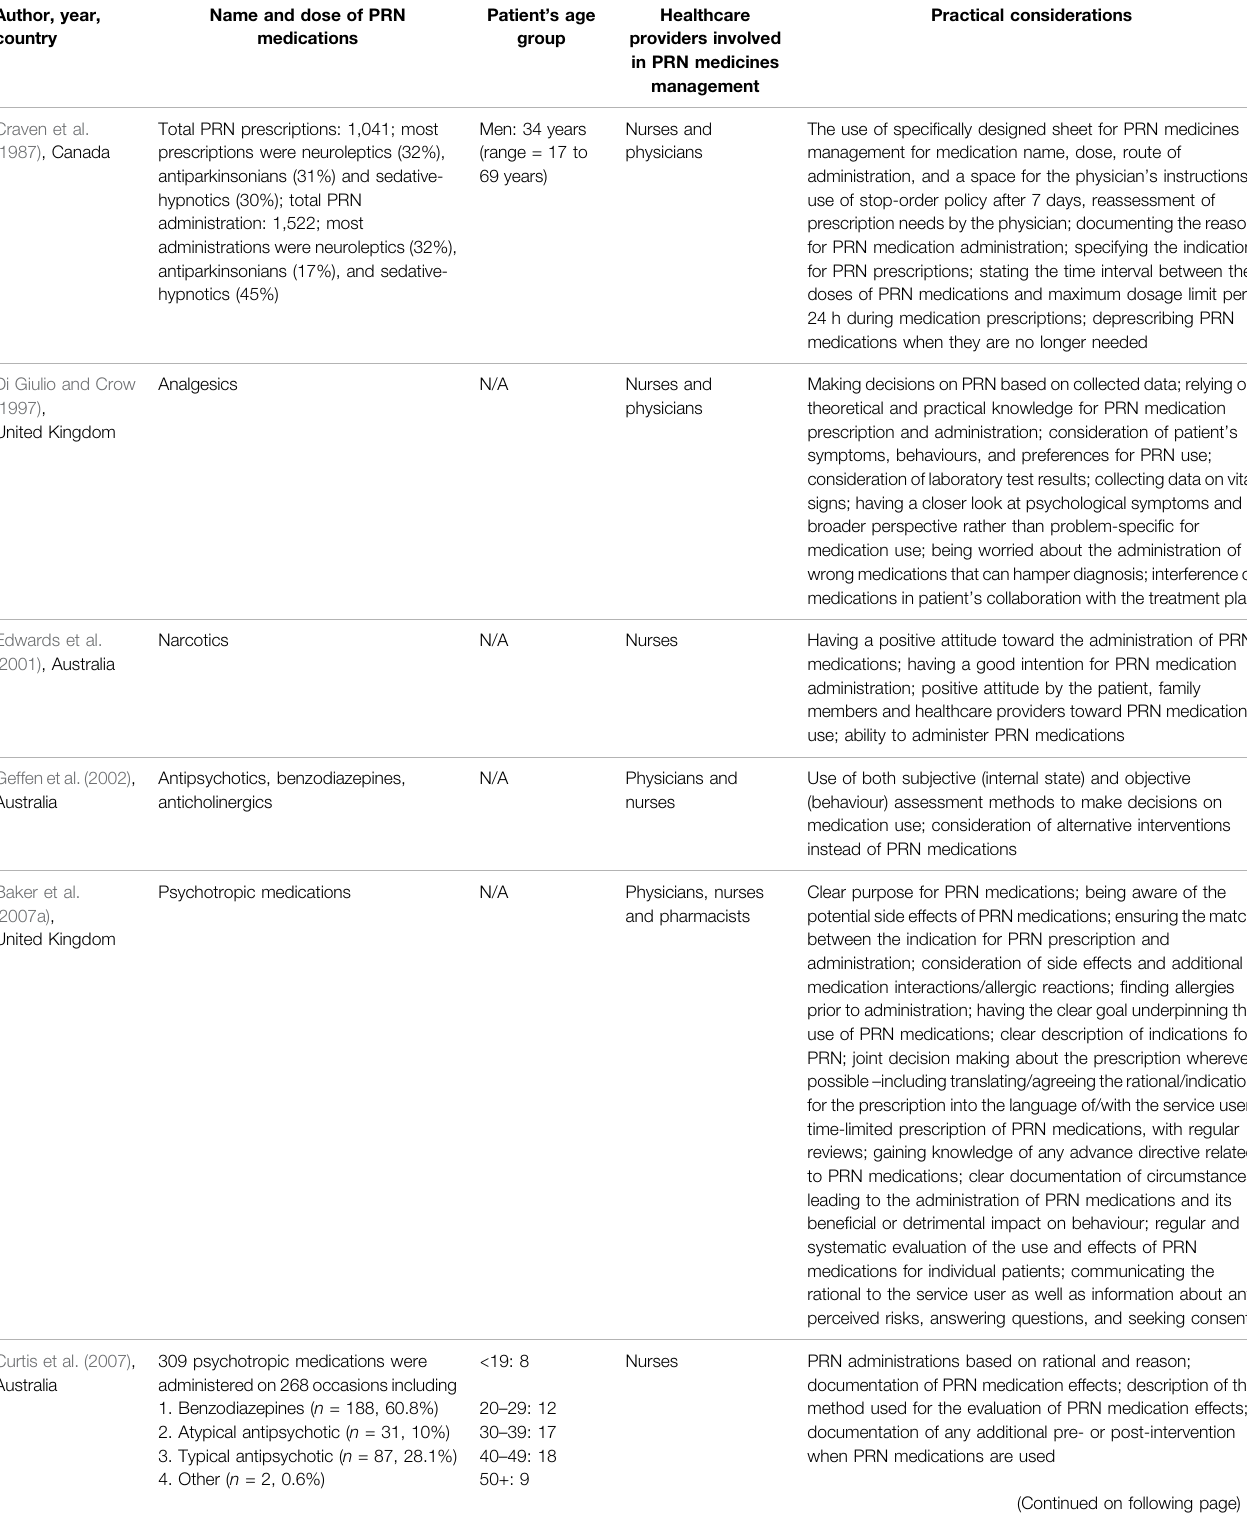
TABLE 3 | PRN medicines management and related practical considerations based on the fi ndings of each included study. Author, year,